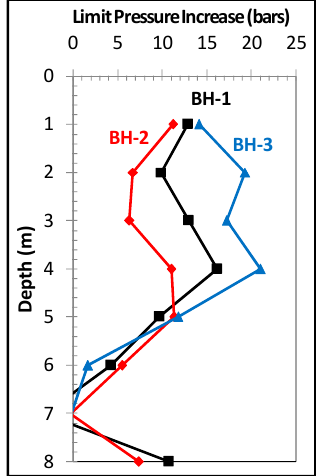
Figure 16. Limit pressure increase due to dynamic compaction.